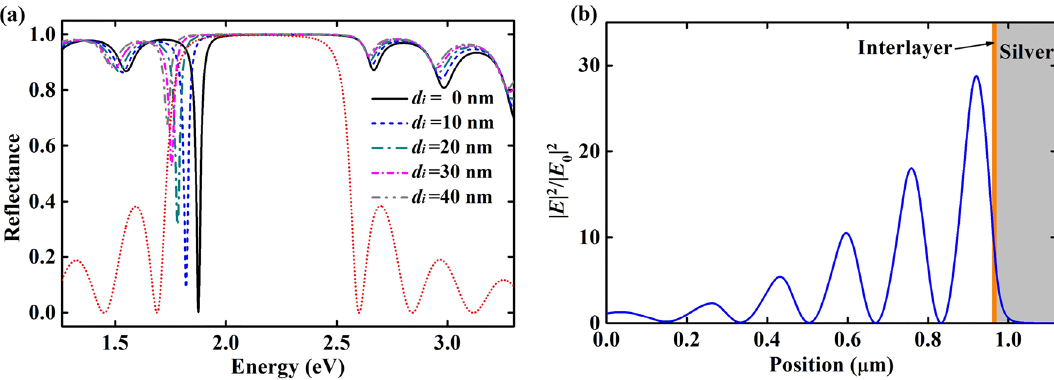
Figure 2. ( a ) Reflectance spectra of the extended Tamm structure at different thickness of interlayer ( d i ). The dotted line is the reflectance spectrum of bare Bragg mirror. ( b ) Optical field distribution of the extended Tamm structure at 1.8204 eV when d i = 10